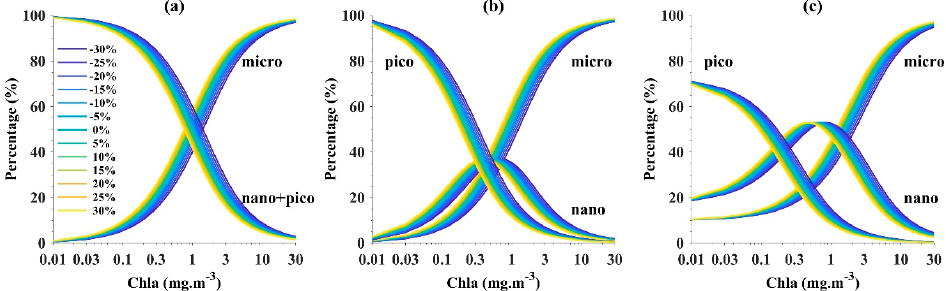
Figure 6. Percentage variation of micro-, mixed nano–pico, nano- and pico- phytoplankton as a function of Chl a (ranging within a range of ±30%) for models ( a ) D, ( b ) E and ( c ) H.